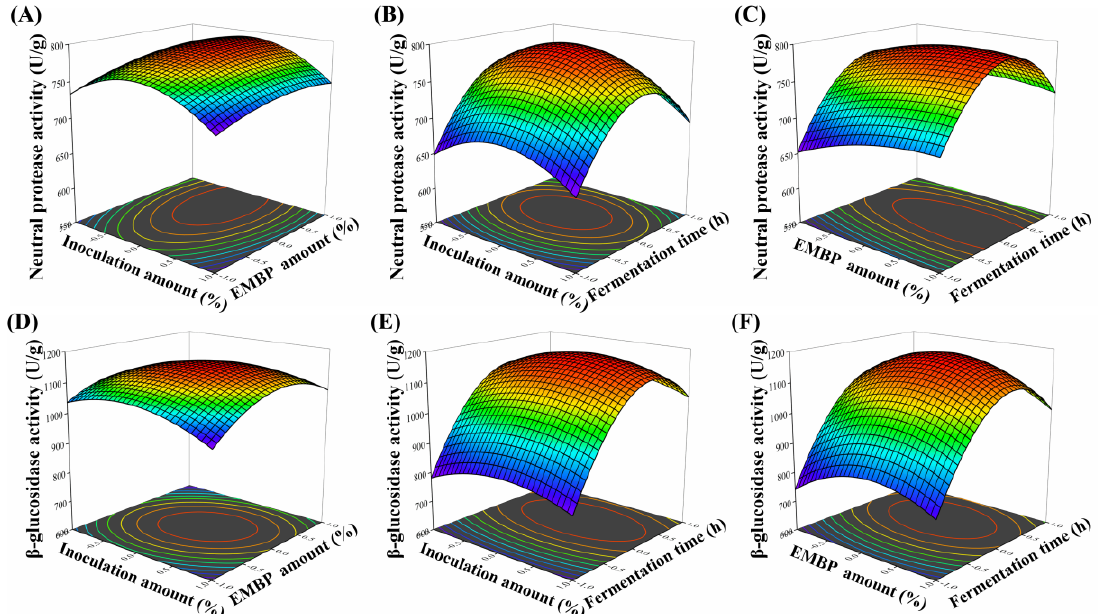
Figure 3. Three-dimensional response surface plots of independent variables on the activities of neutral protease ( A – C ) and β -glucosidase ( D – F ). neutral protease ( A – C ) and β -glucosidase ( D – F